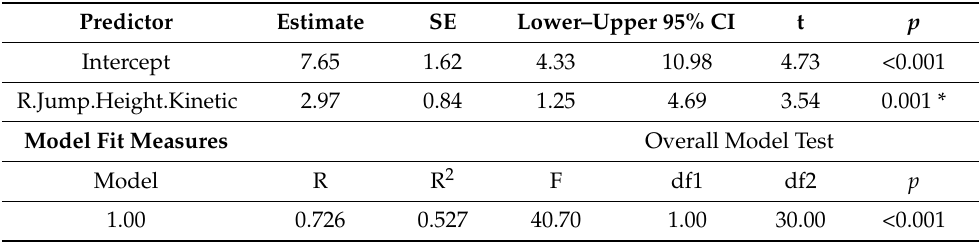
Table 5. Linear regression of right Side (based on